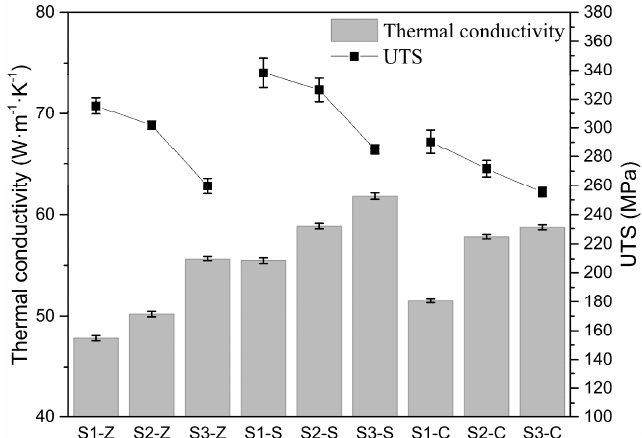
Figure 8. Tensile strength and thermal conductivity of all compositions. Error bars are ± one standard deviation.